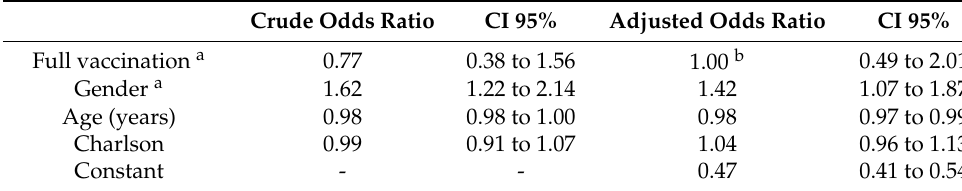
Table 3. Explanatory model of ICU admission.